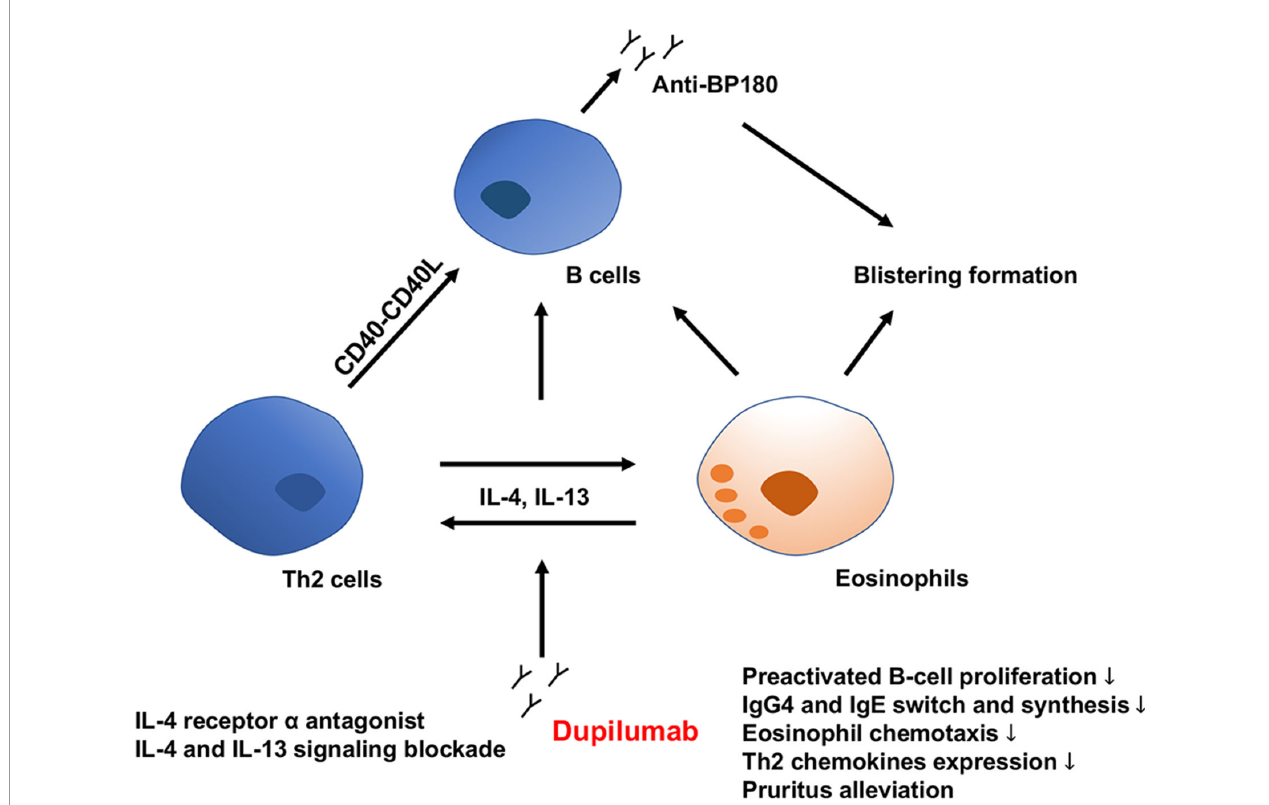
FIGURE 1 | Direct and indirect activities of dupilumab in the immunopathogenesis of BP. BP, bullous pemphigoid; IL, interleukin; Th2, type 2 T helper; Ig,